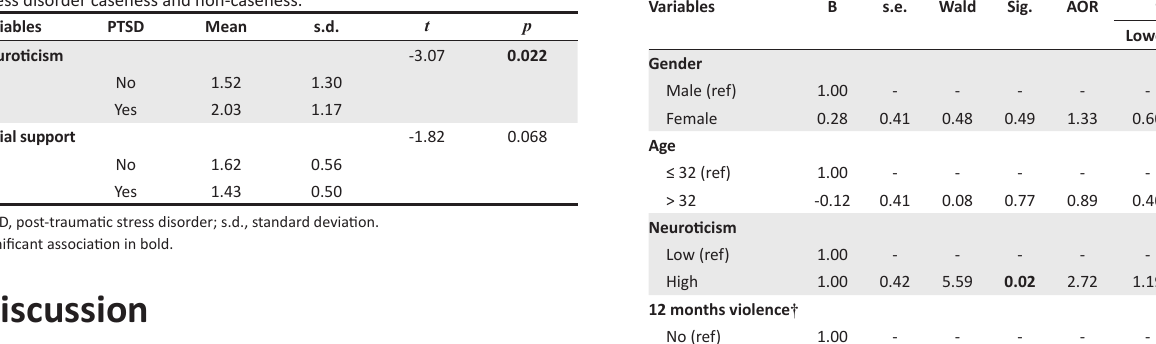
TABLE 4: Predictors of post-traumatic stress disorder caseness.